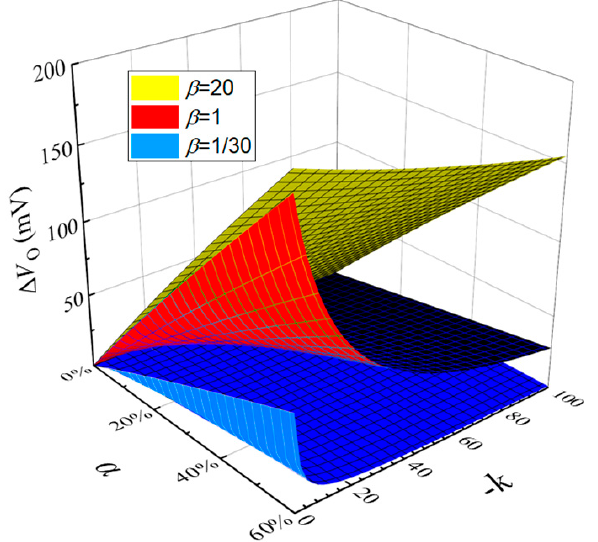
Figure 3. PDMC ∆ V O as functions of the gain of the inversion amplifier and the impedance mismatch coefficient of two acquisition electrodes for C-DRL method. It increases with the increase of the impedance mismatch coefficient α for constant β and | k |, decreases with the increase of | k | in a certain range and is almost unchanged for | k | larger than a certain value. PDMC can also be further suppressed by the decrease of β for constant | k |.